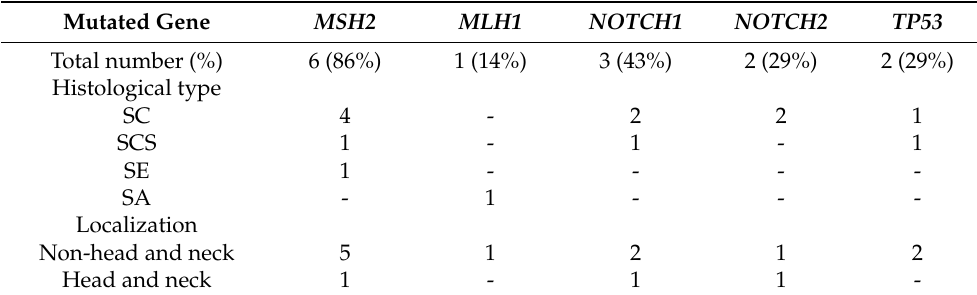
Figure 3. ( a ) Pedigree of patient 1 shows the autosomal dominant transmission of skin and visceral tumors; ( b ) patient 7 with MTS associated tumors in family members ( c ); patient 7 has a brother with a lung tumor; ( d ) Legend. Table 3. Most frequent